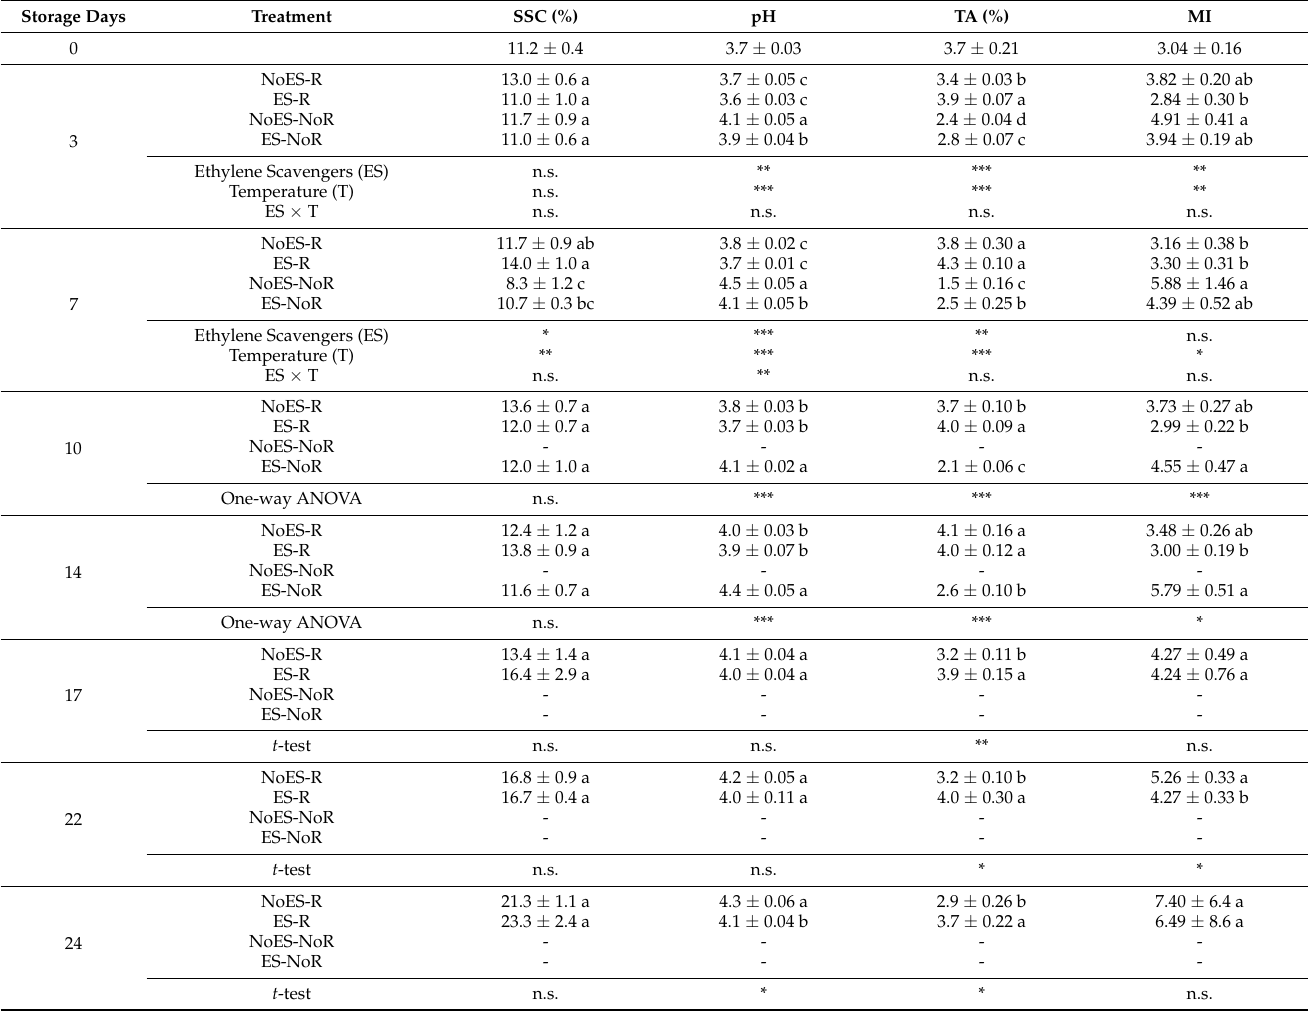
Table 2. Evolution during storage time of the maturity parameters in peaches subjected to different treatments (NoES-R, ES-R, NoES-NoR and ES-NoR). The parameters measured were SSC expressed as percentage, pH, TA expressed as percentage, MI as the SSC/TA ratio.